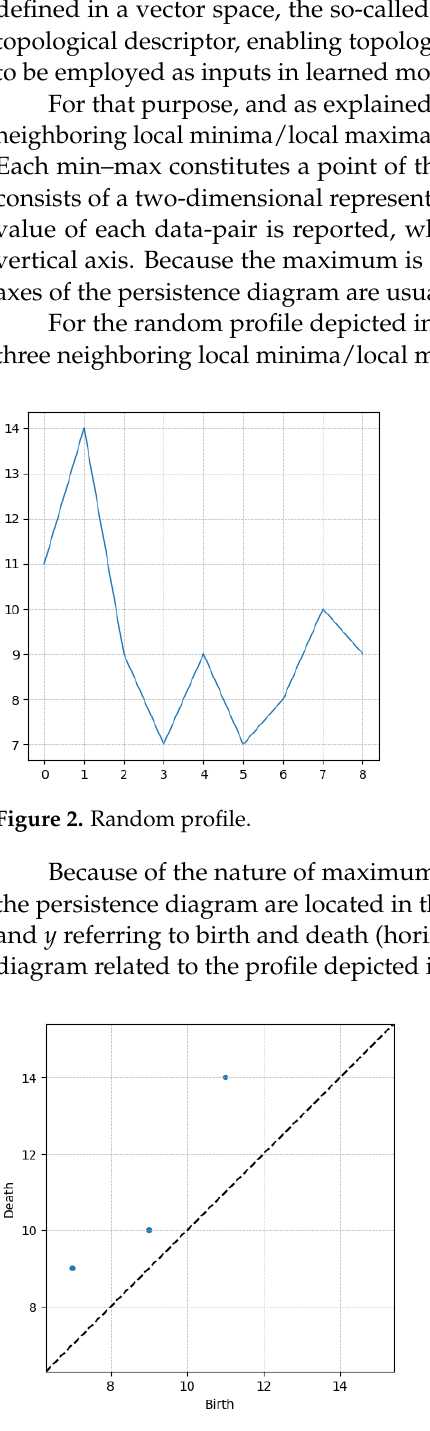
Figure 3. Typical persistence diagram PD